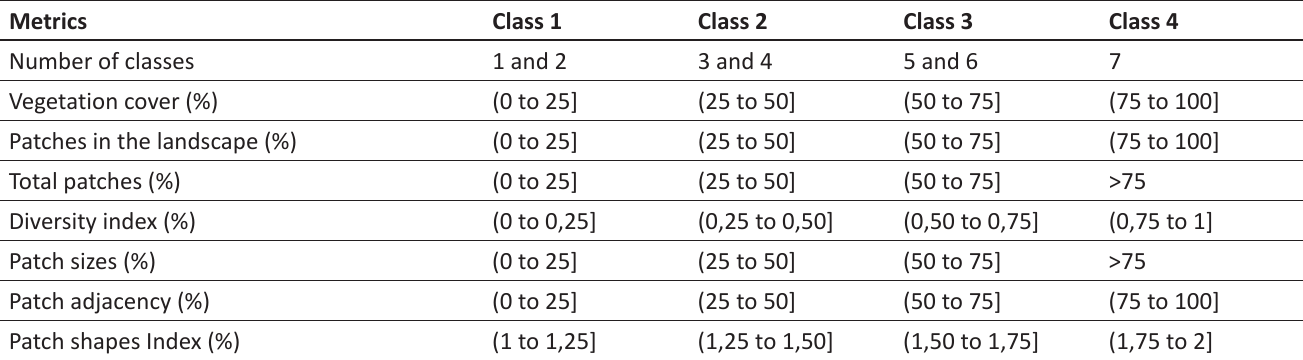
Table 2: Categorization (four classes) of the chosen metrics